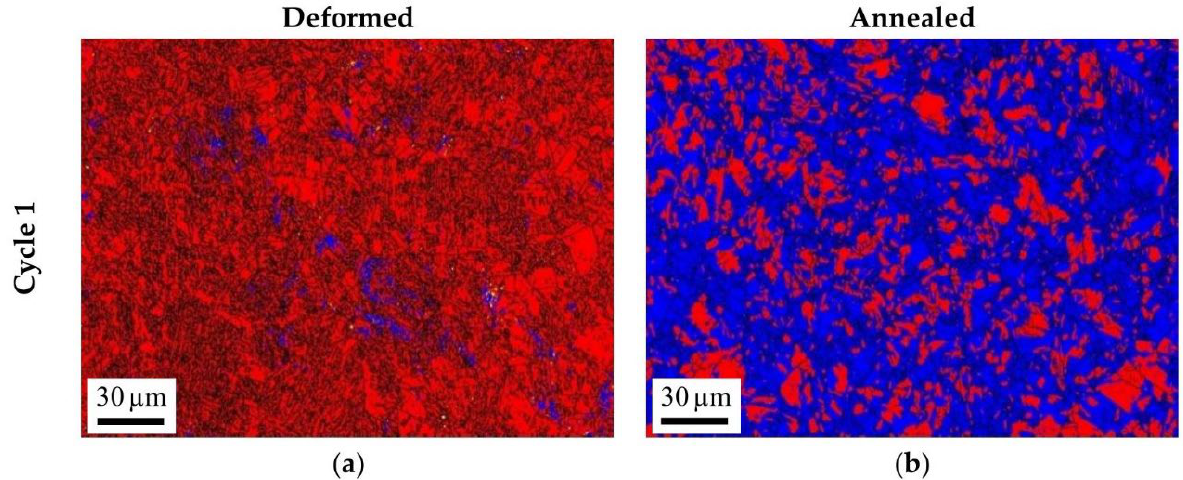
Figure 1. Phase maps for TMP samples processed using one cycle and strain of 0.30: ( a ) Deformed structure and ( b ) annealed structure. Austenite is blue, α′ - martensite is red, and ε -martensite is yellow.